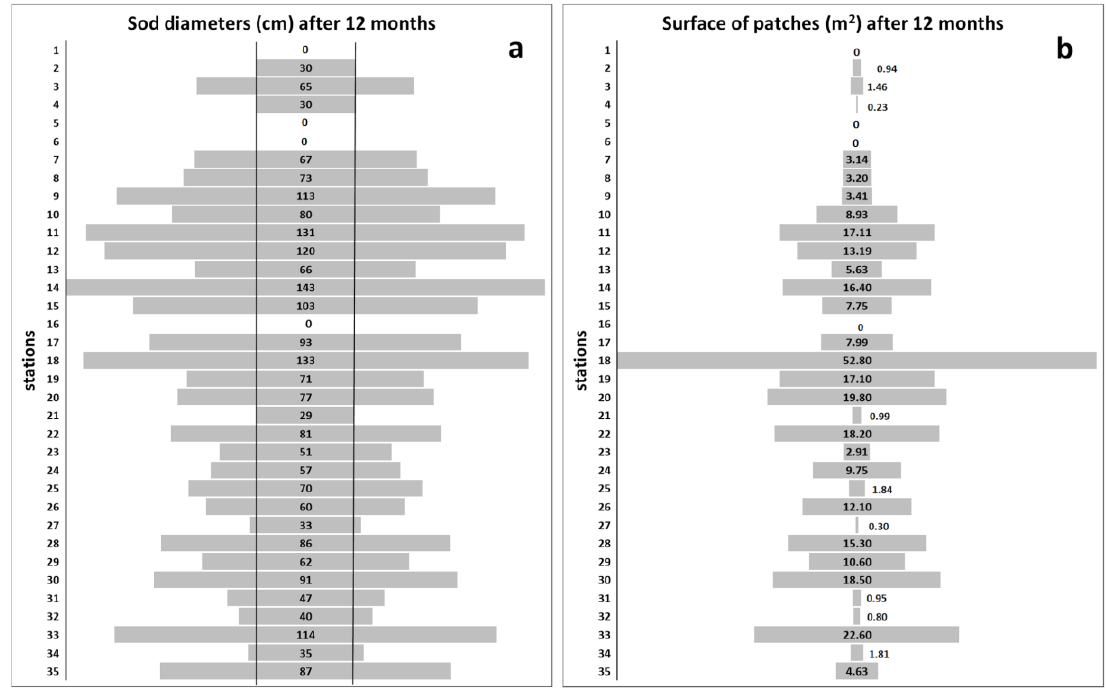
Figure 3. ( a ) Average diameters of the patches. Vertical bars represent the diameter of the transplanted sods; ( b ) Total surface of patches, formed by the growth of sods and rhizomes at the 35 sampling sites after 12 months. Only patches with a diameter > 20 cm were considered.